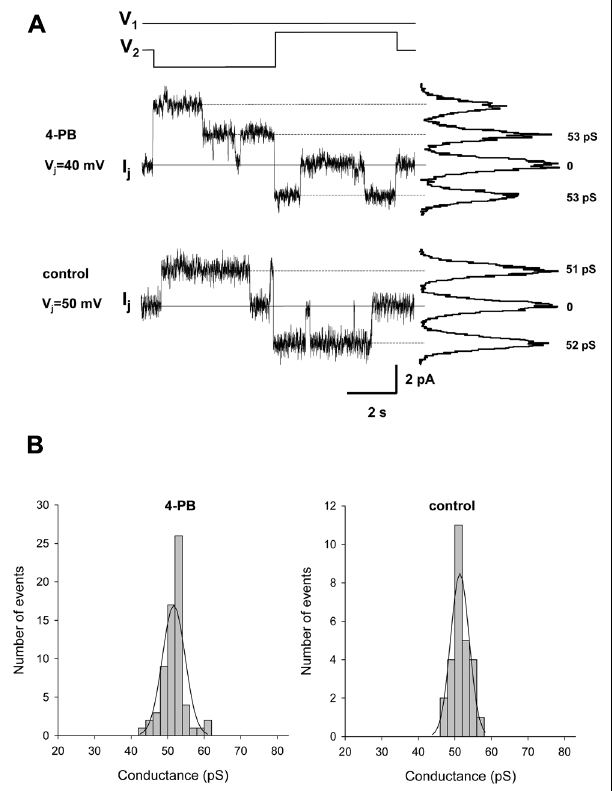
FIGURE 4 | Single channel properties of gap junction channels. (A) Single channel currents elicited by bipolar V j pulses ( V 1 and V 2 ) of 40 mV (top I j trace) and 50 mV (middle I j trace) in HeLa Cx43 cell pairs with 4-PB exposure and control conditions, respectively. Continuous lines indicate zero current level.The current histograms (right) revealed 53 pS and 51–52 pS conductance levels, for 4-PB exposed and control cells, respectively. (B) Histograms of single channel conductances for 4-PB treated (left panel) and control (right panel) cells.The smooth curves represent fits of data to Gaussian distributions. For specific data see text.